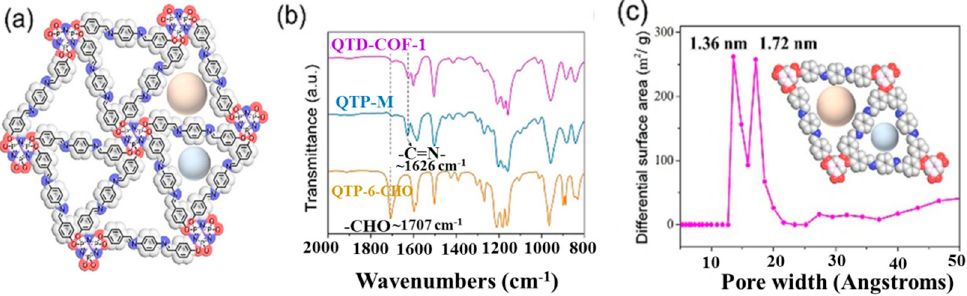
Figure 5. ( a ) Crystal structure of QTD-COF-1. ( b ) FT-IR spectra. ( c ) Pore-size distribution for QTD-COF-1.Reprinted/adapted with permission from Ref. [60]. Copyright (2020), John Wiley and Sons.